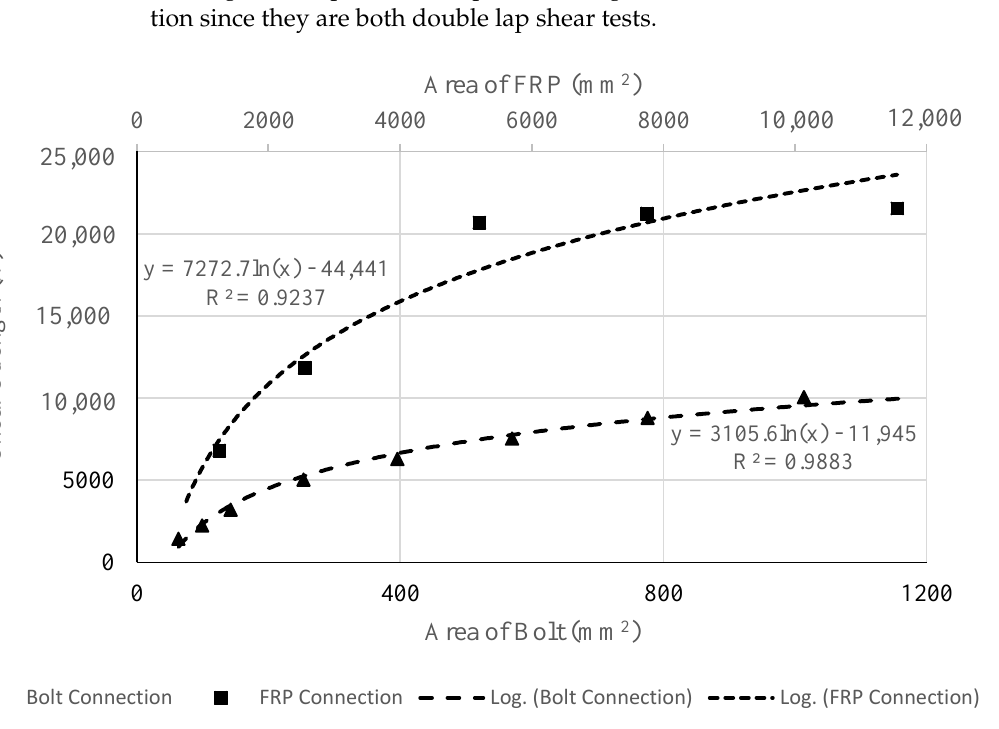
Figure 18. Comparison of regression models for FRP tie and bolted wood–to–metal connections.